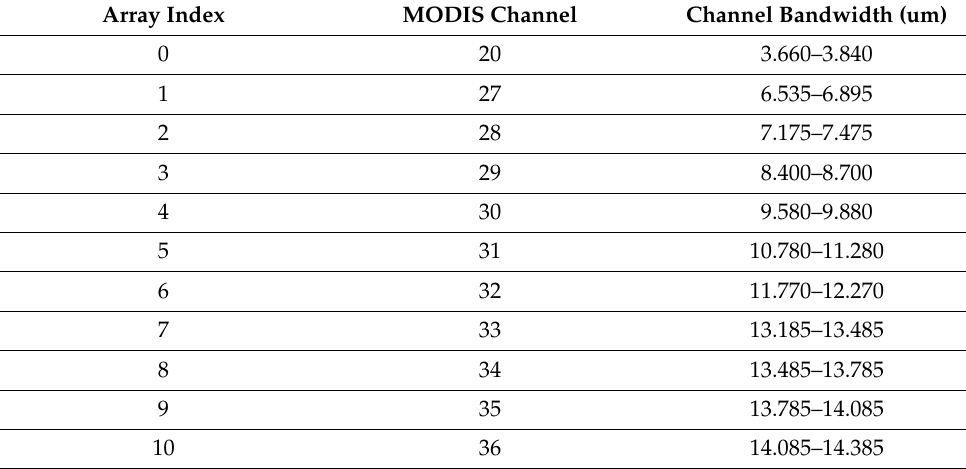
Table A4. Channel bandwidth for the 11 MODIS IR and near-IR channels included in the MODIS- AUX